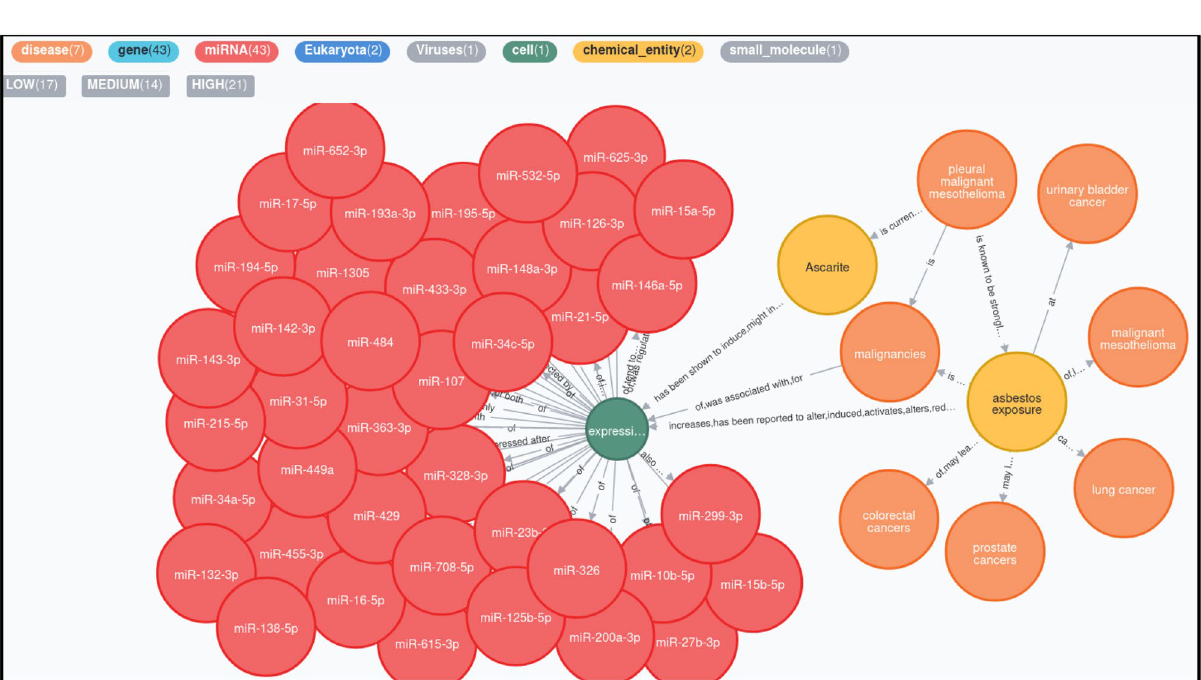
Figure 9. Mesothelioma-miRNAs network showing the relationships among pleural malignant mesothelioma disease and miRNAs derived from the PubMed Central full texts by using NetME tool. Such a network has been queried and displayed through Neo4j graph database and user